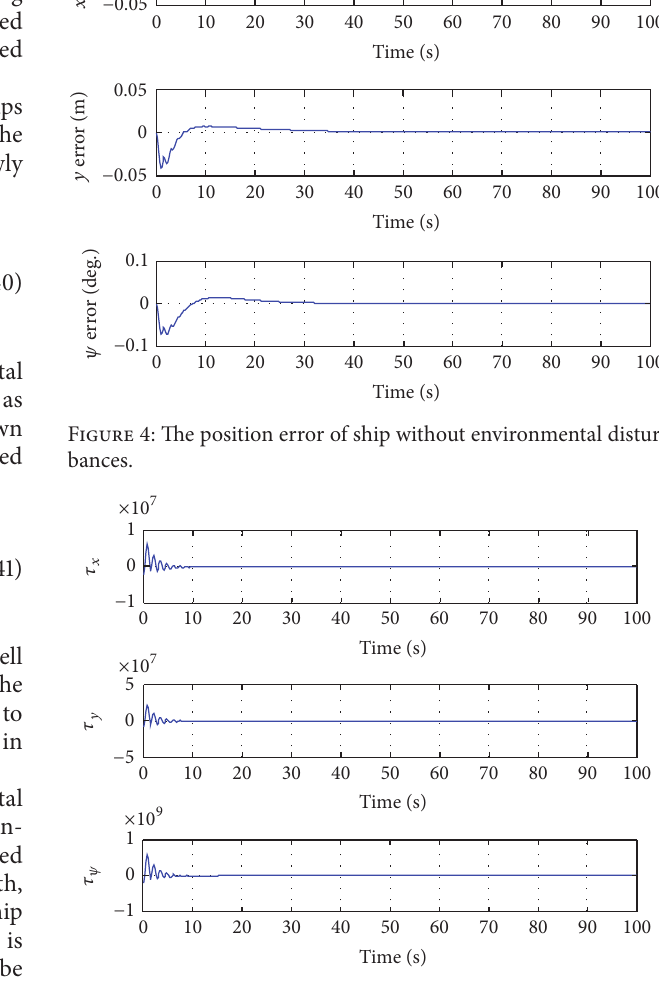
Figure 5: The curves of 𝜏 without environmental